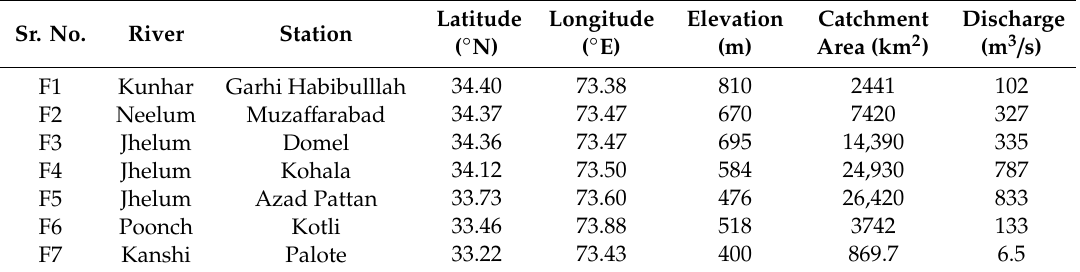
Table 1. Basic information about hydrological stations, discharge is for 1976–2005. Sr.